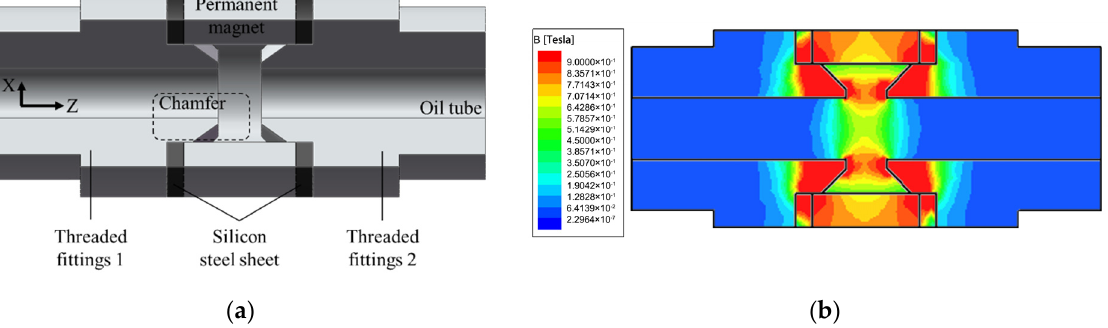
Figure 5. Three-dimensional simulation in ANSYS Maxwell: ( a ) structure; ( b ) cross section of simulation result.